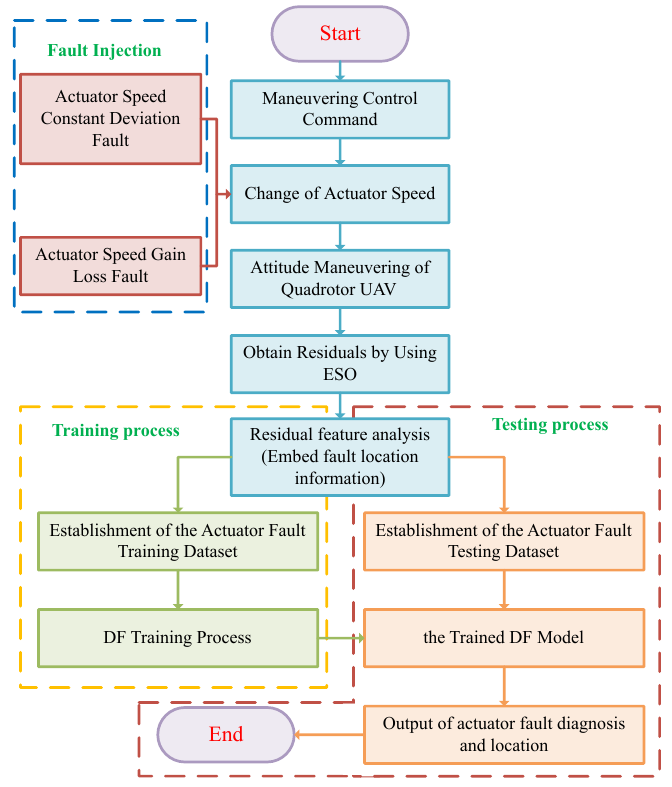
Figure 5. Flow chart of the ESO-DF based actuator fault diagnosis and localization scheme. The entire process can be split into two parts: training and testing. The specific steps are set out